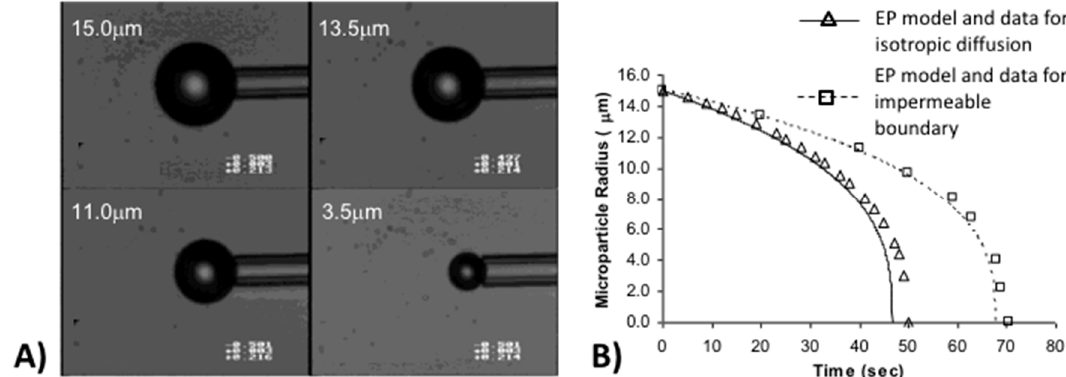
Figure 21. Dissolution of a 30 µ m diameter air bubble into water. ( A ) A series of video images of the dissolution of an air microbubble in 10 mM SDS solution held in the center of the chamber by a pipet with a very low suction pressure of 500 Pa and 21.5 ◦ C. The air bubble is shown at times 0 s (top left), 10 s (top right), 30 s (bottom left), and 48 s (bottom right) respectively, completely dissolving in ~50 s. ( B ) Plot of microparticle radius versus time for dissolution in isotropic and boundary-limited conditions where the data are fitted by the Epstein–Plesset (EP) model and an empirical model by Wise et al. [166] .